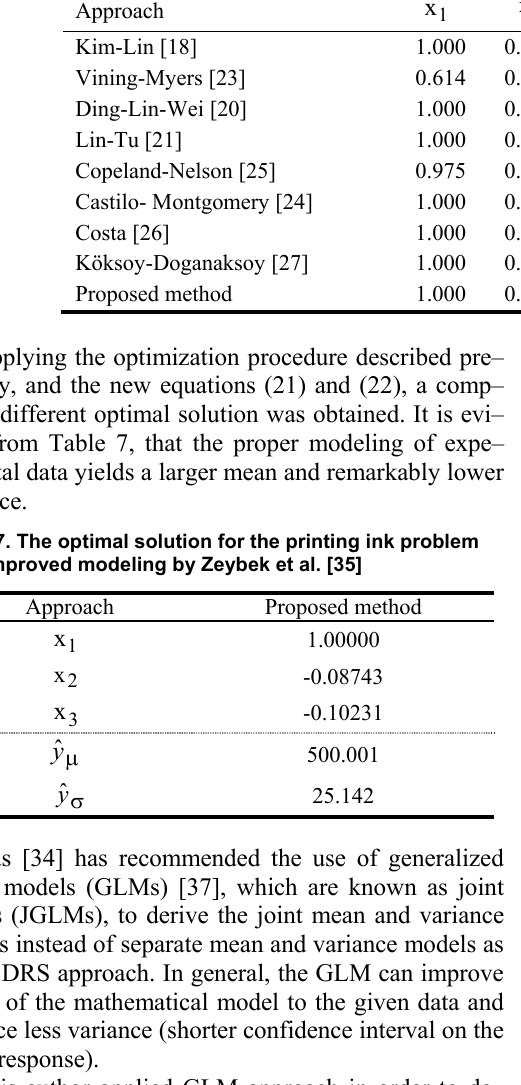
Table 6. Comparison of the optimal results obtained by different methods Approach